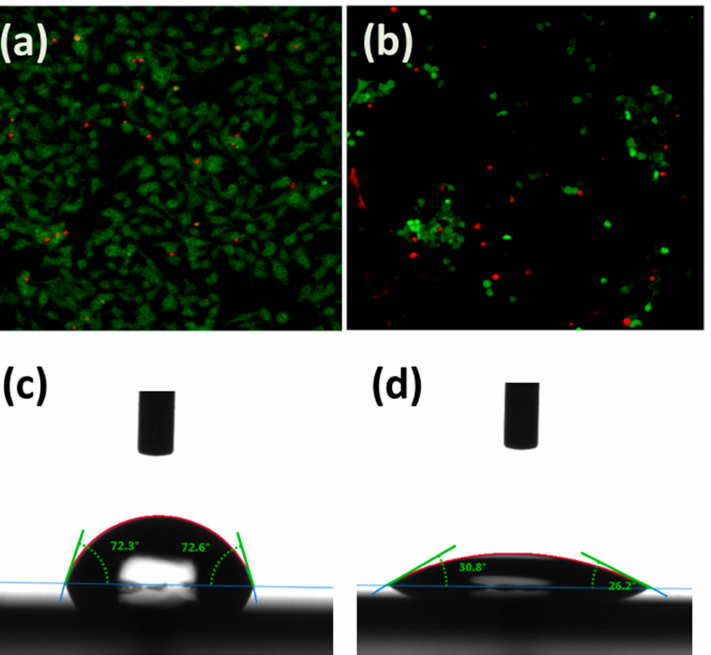
Figure 5. Cells cultured on different materials: ( a ) on Si; ( b ) on amorphous WN x . Contact angle measurements on ( c ) Si and ( d ) WN x